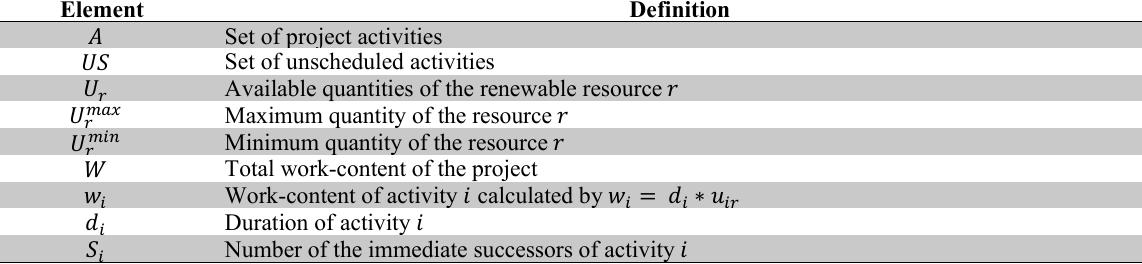
The priority rules and their selection criteria